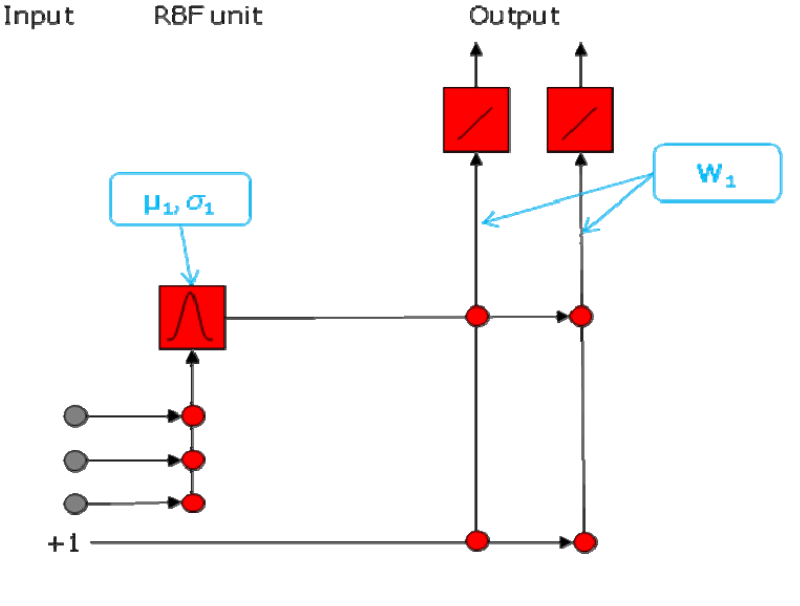
Figure 5. Adding second hidden neurons into a RBFCCN. This network has three input neurons, two hidden neurons and two output neurons. The neurons and connections being trained are marked in red. µ